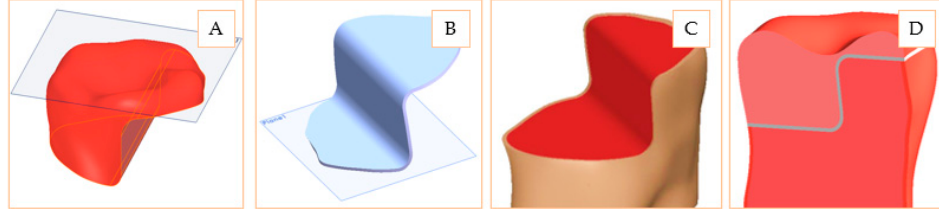
Figure 3. Design stages of onlay model: Ceramic restoration ( A ); Adhesive cement ( B ); Dentin and enamel model ( C ); Complete onlay model ( D ).